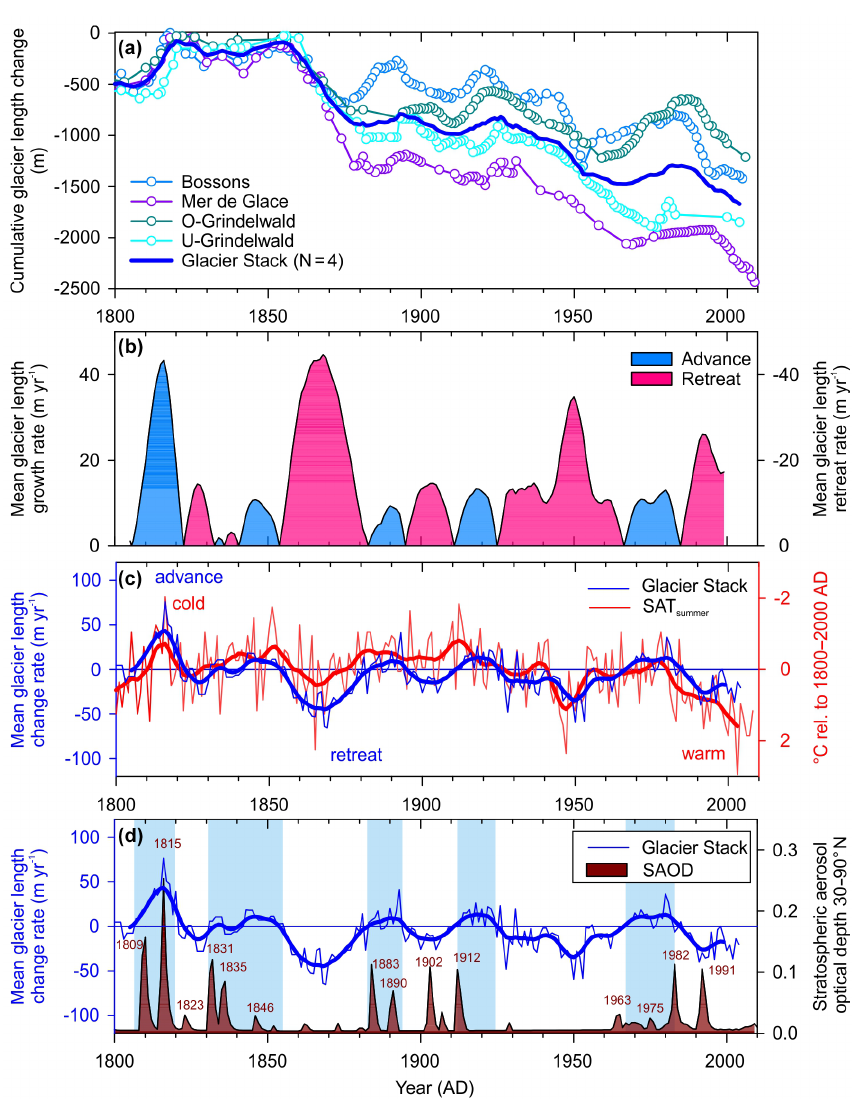
Figure 8. (a) Cumulative glacier length changes for the four glaciers Bossons, Mer de Glace, Oberer (O-) Grindelwald and Unterer (U-) Grindelwald and their average (glacier stack; missing observations were filled using linear interpolation); (b) mean glacier length change rate (smoothed with a 11-year filter) of the glacier stack length record indicating phases of average glacier advances (blue shading) and of glacier retreat (red shading), respectively; (c) smoothed and annual resolution mean glacier length change rates of the glacier stack and equally resolved surface air temperature anomalies for the summer half year (SAT summer ) from the Greater Alpine Region HISTALP station network (Böhm et al., 2010); Panel (d) is as in (c) but with stratospheric aerosol optical depth (SAOD) at 550nm based on ice cores (1800–1850: Toohey and Sigl, 2017) merged with the CMIP6 (version 2) reconstruction (1850–2000: Luo, 2016; Eyring et al.,